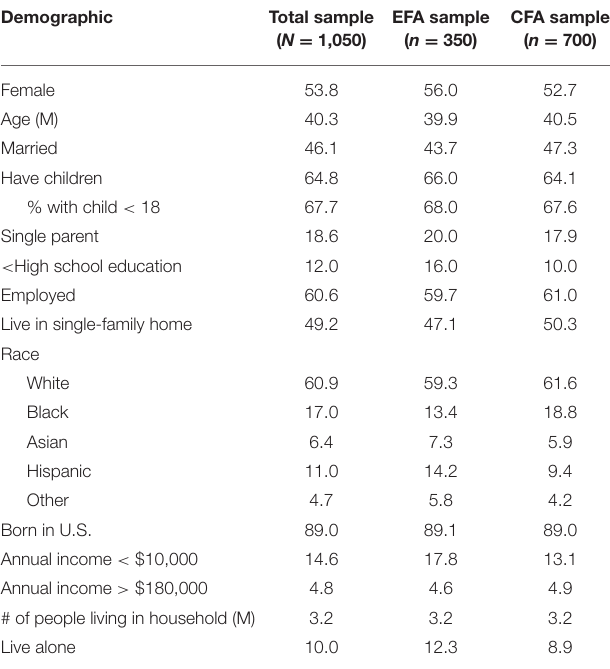
TABLE 1 | Demographic characteristics of the